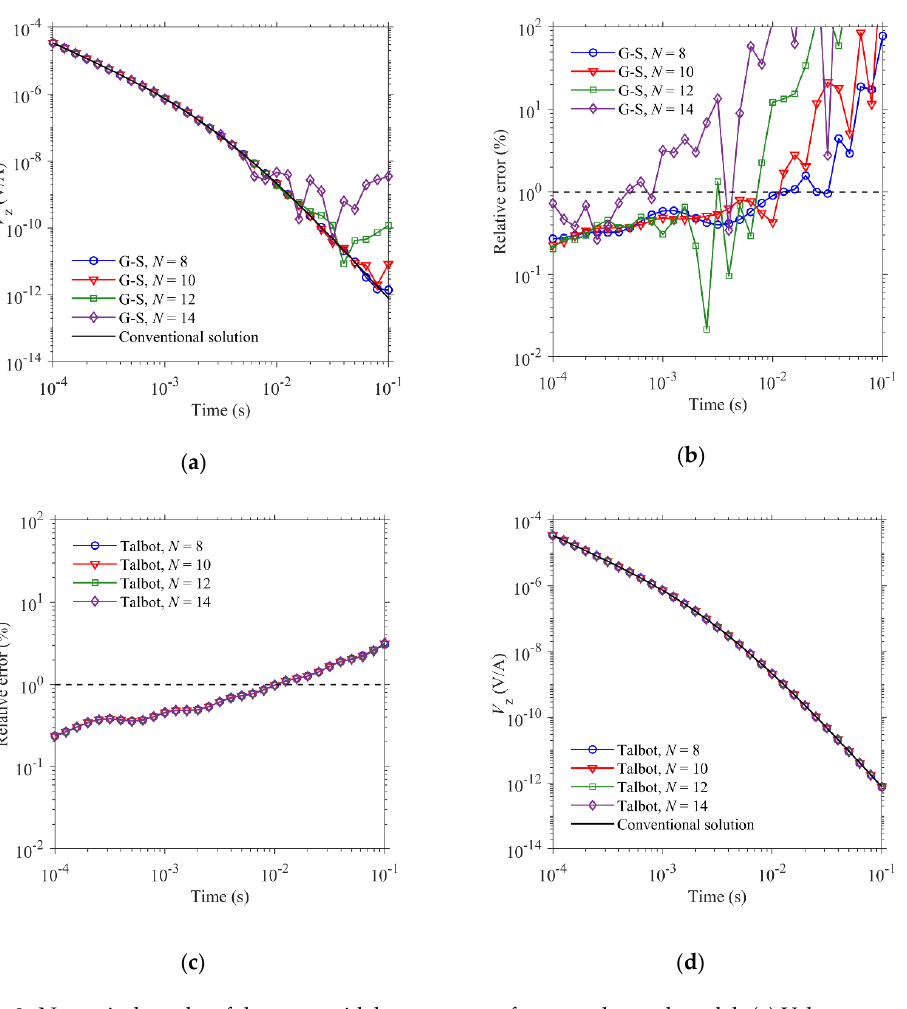
Figure 3. Numerical results of the trapezoidal wave source for a two-layered model. ( a ) Voltage response of the G-S algorithm; ( b ) errors of the G-S algorithm relative to the conventional solution, where the dashed line indicates a relative error of 1%; ( c ) voltage response of the Talbot algorithm; ( d ) errors of the Talbot algorithm relative to the analytic solution, where the dashed line indicates a relative error of 1%.